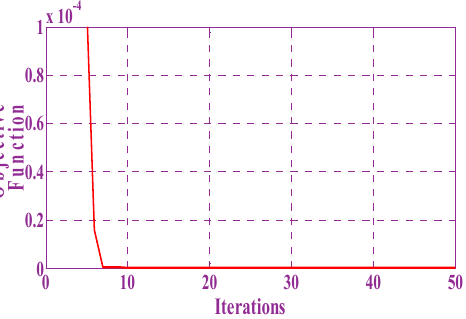
Figure 6. Convergence curve for SOS for the SHE nine-level problem with modulation index = 1.